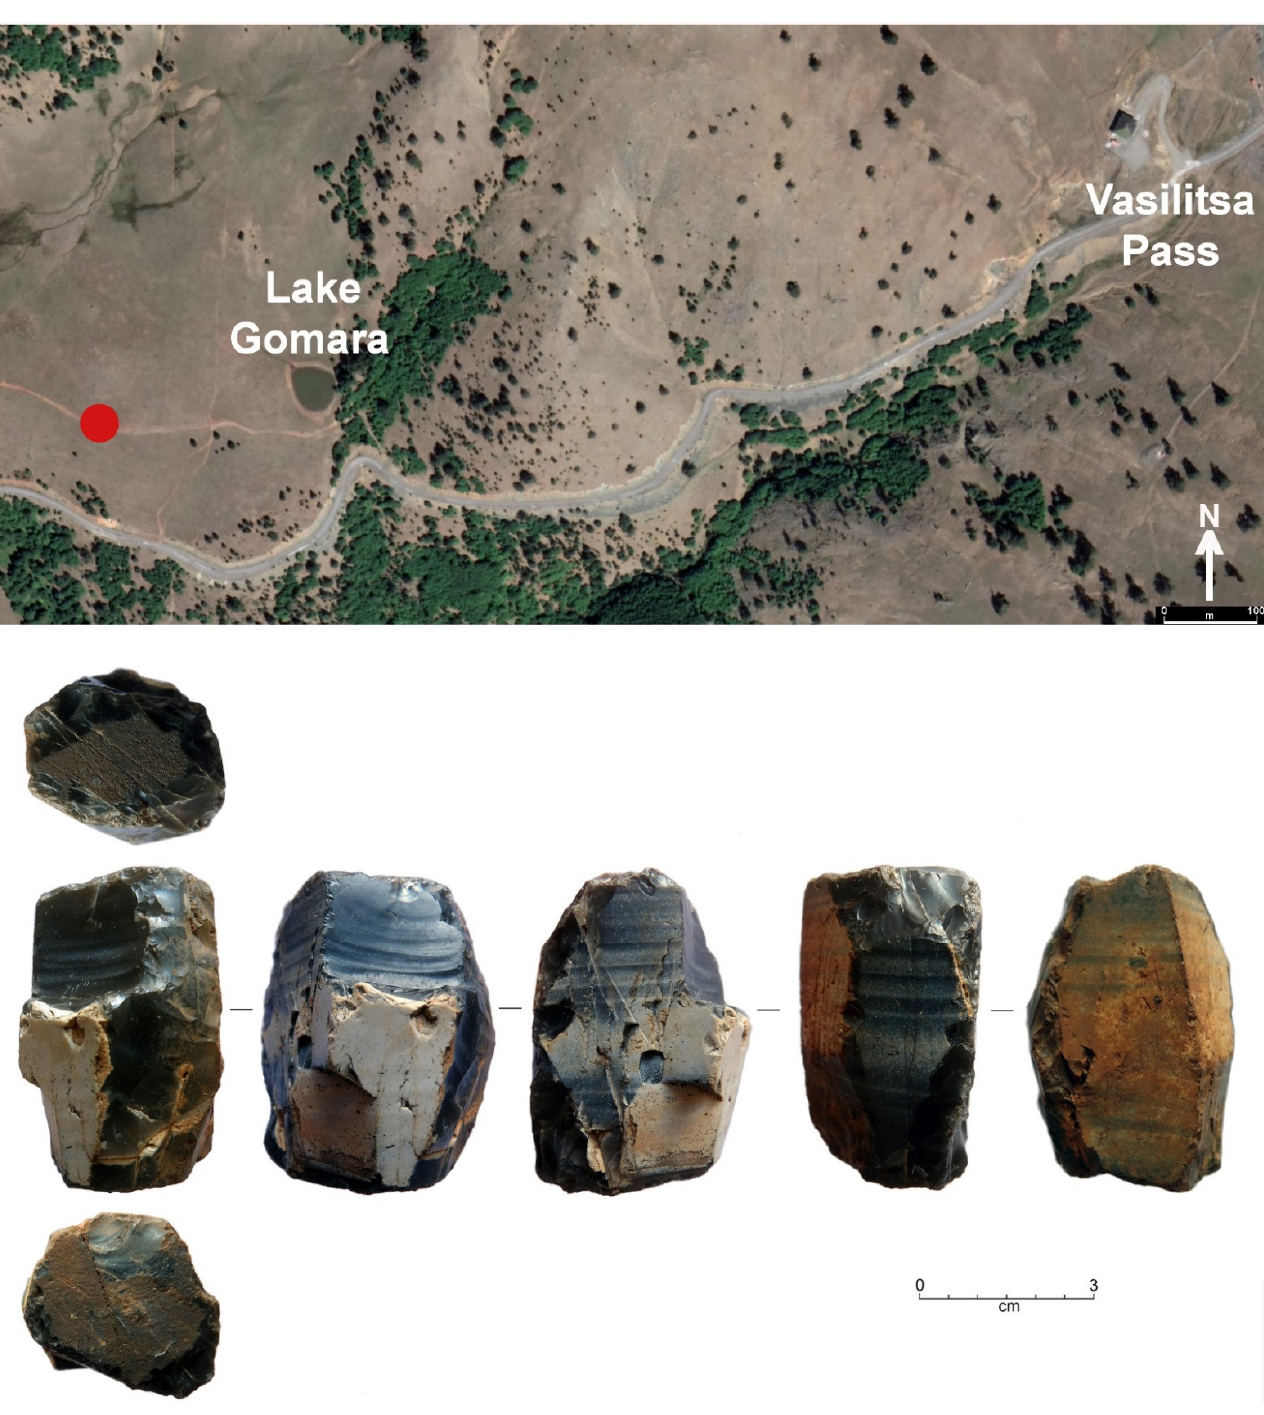
Figure 4. Lake Gomara, along the southern slope of Mount Baltoumis ( top ), and location of the pre-core of Vikos “black chert” recovered from the surface ca. 200 m west of the small basin (red dot) ( bottom ) (photographs by E. Starnini, 2022).